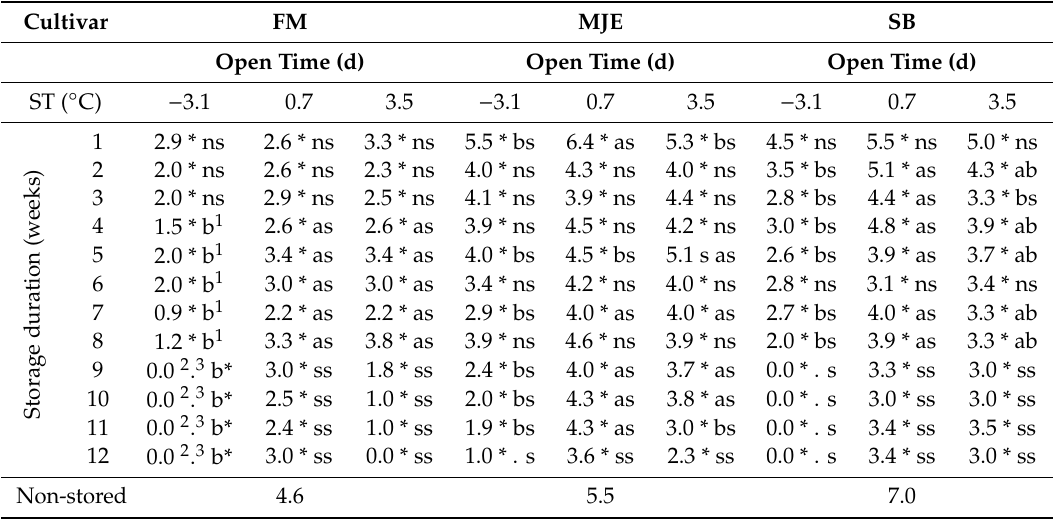
Table 1. Mean flower open time (d) in response to storage temperature (ST) and storage duration for Paeonia lactiflora cultivars Festiva Maxima (FM), Monsieur Jules Elie (MJE), and Sarah Bernhardt (SB) peonies, analyzed separately in Exp1. Grand mean bud time for FM, MJE, and SB was 1.2, 1.3, and 1.2 d,